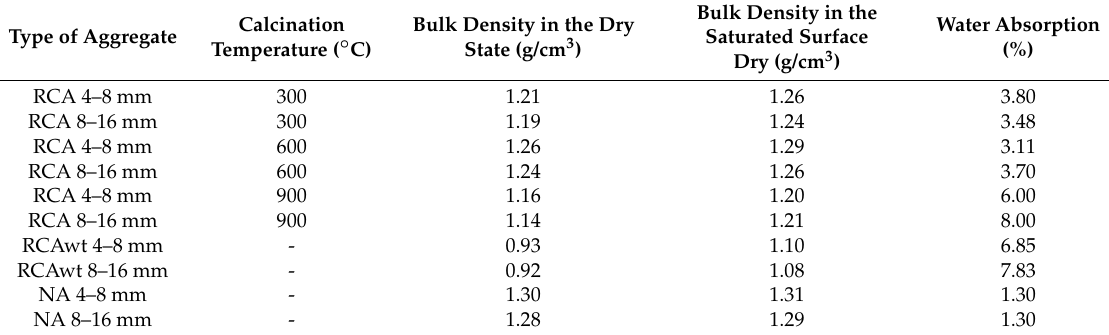
Table 7. Properties of recycling and natural